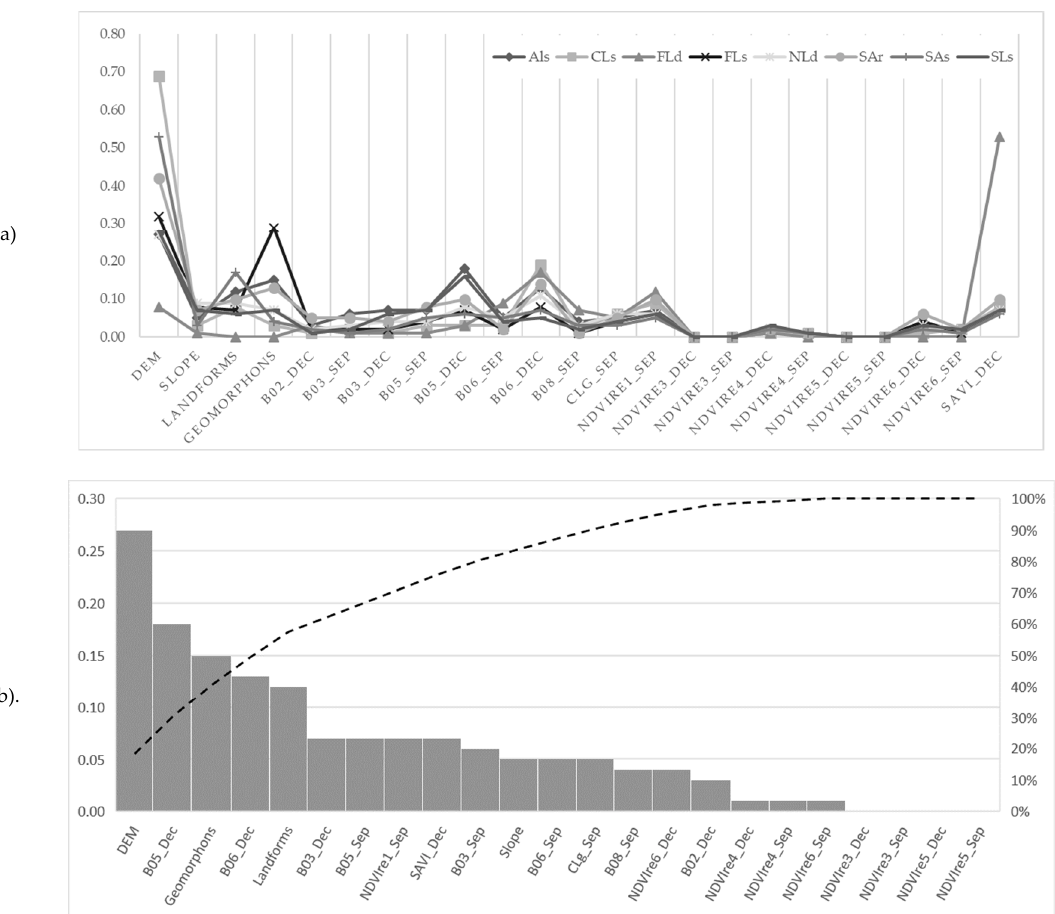
Figure 6. Graphical of relative covariates importance for modeling phytophysiognomies. ( a ) The relative importance of each physiognomy; ( b ) average cumulative relative importance. DEM = Elevation. Bands and indices assigned as ‘Sep’ correspond to September images (dry season), while those assigned as ‘Dec’ correspond to December images (wet season). B02, B03, B05, B06, and B08 = Selected Sentinel-2 MSI bands; NDVIre = Normalized difference vegetation index red-edge; CLg = Green chlorophyll index; SAVI = Soil-adjusted vegetation index.